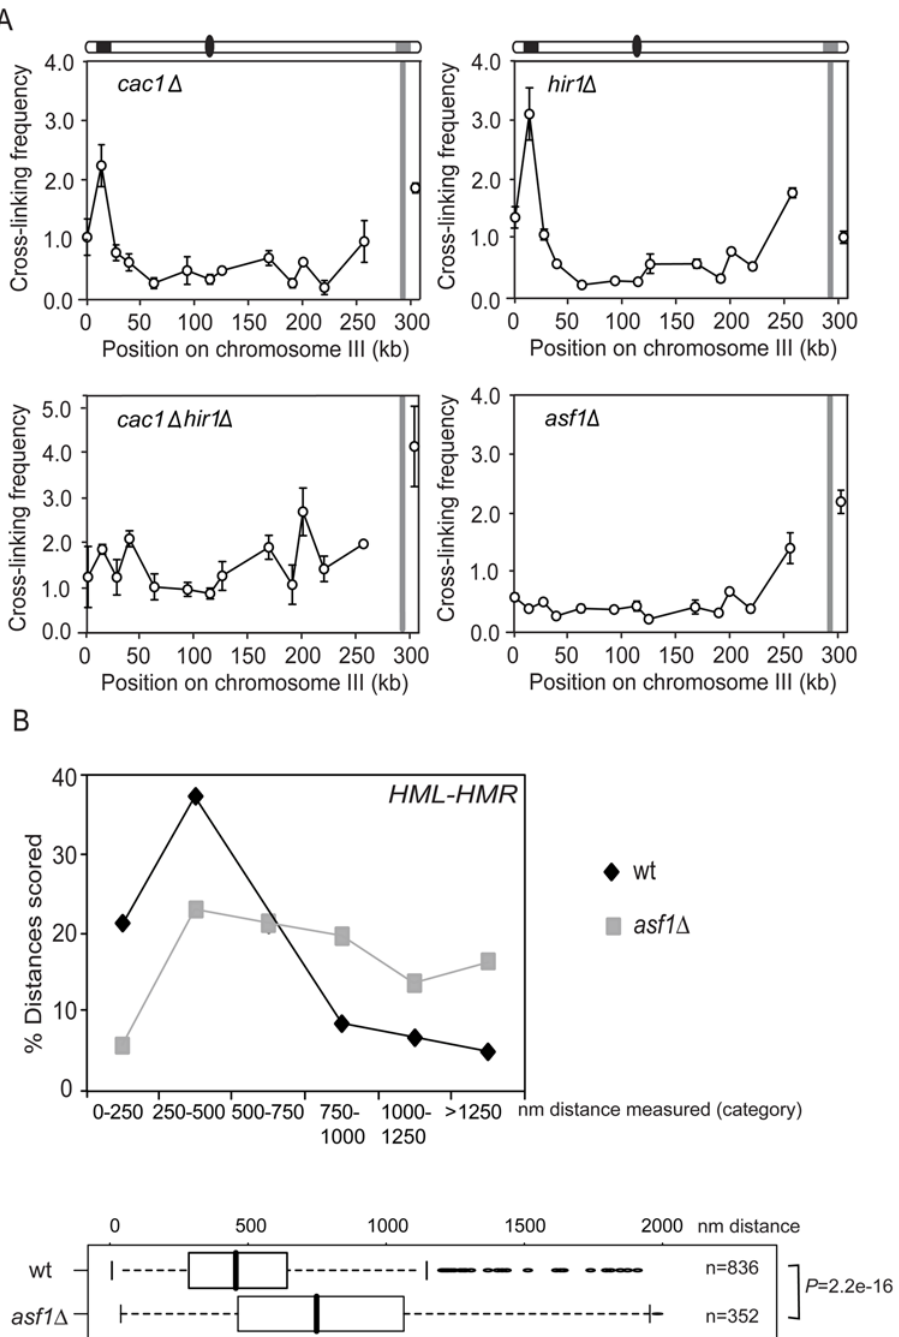
Figure 7. Role of nucleosome assembly factors in HM interactions. (A) Analysis of interactions in cac1 D , hir1 D , cac1 D hir1 D , and asf1 D cells examining crosslinking frequencies between the Eco RI fragment containing HMR with other restriction fragments along the length of chromosome III. (B) 3D live cell analysis of HML-HMR colocalization in asf1 D cells. Image stacks were acquired and analyzed as in Figure 1. Distance distributions of various telomere pairs represented in box plots. Probabilities were calculated in R using the Wilcox